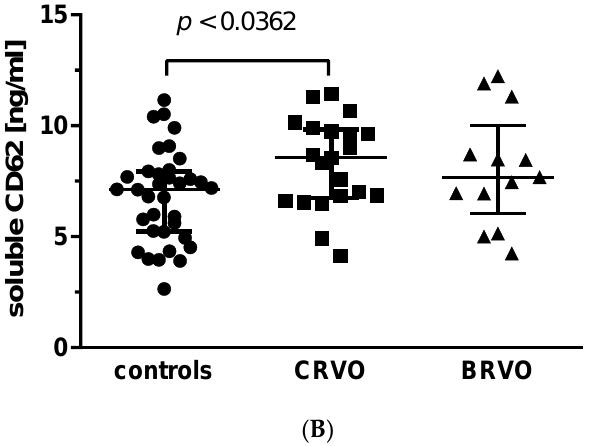
Figure 3. Soluble P-selectin levels (CD62s) are elevated in RVO patients vs. controls ( A ) and in CRVO patients vs. controls ( B ). The graphs present the dot-plots with median (horizontal bar) and interquartile range (Q1; Q3) (whiskers). Significance of differences between RVO and controls was estimated using the Mann – Whitney U test ( A ) and between CRVO or BRVO and controls using one-way analysis of variances (ANOVA) with Bonferroni ’ s multiple comparisons test ( B ). BRVO — Branch Retinal Vein Occlusion, CRVO — Central Retinal Vein Occlusion, RVO — Retinal Vein Occlusion.